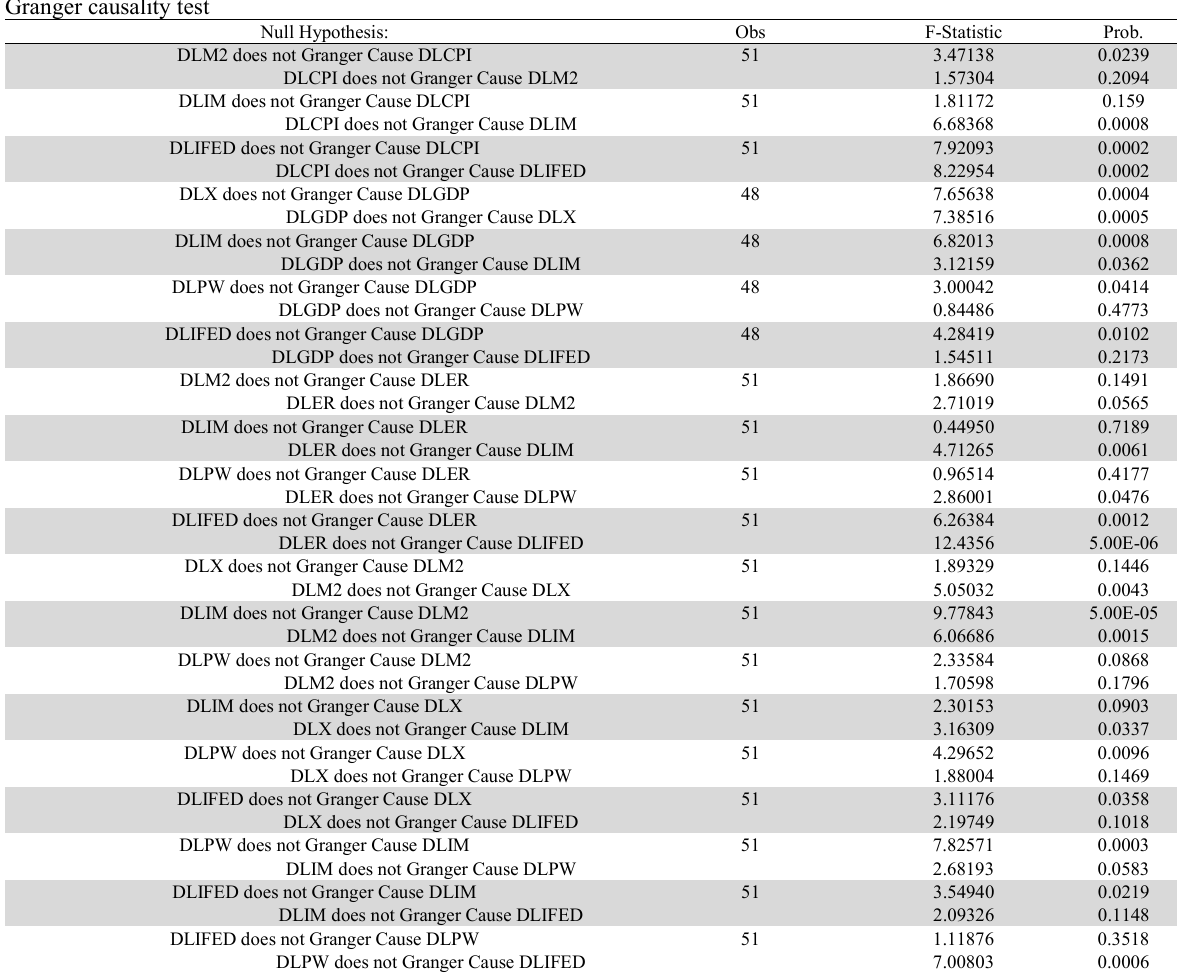
Granger causality